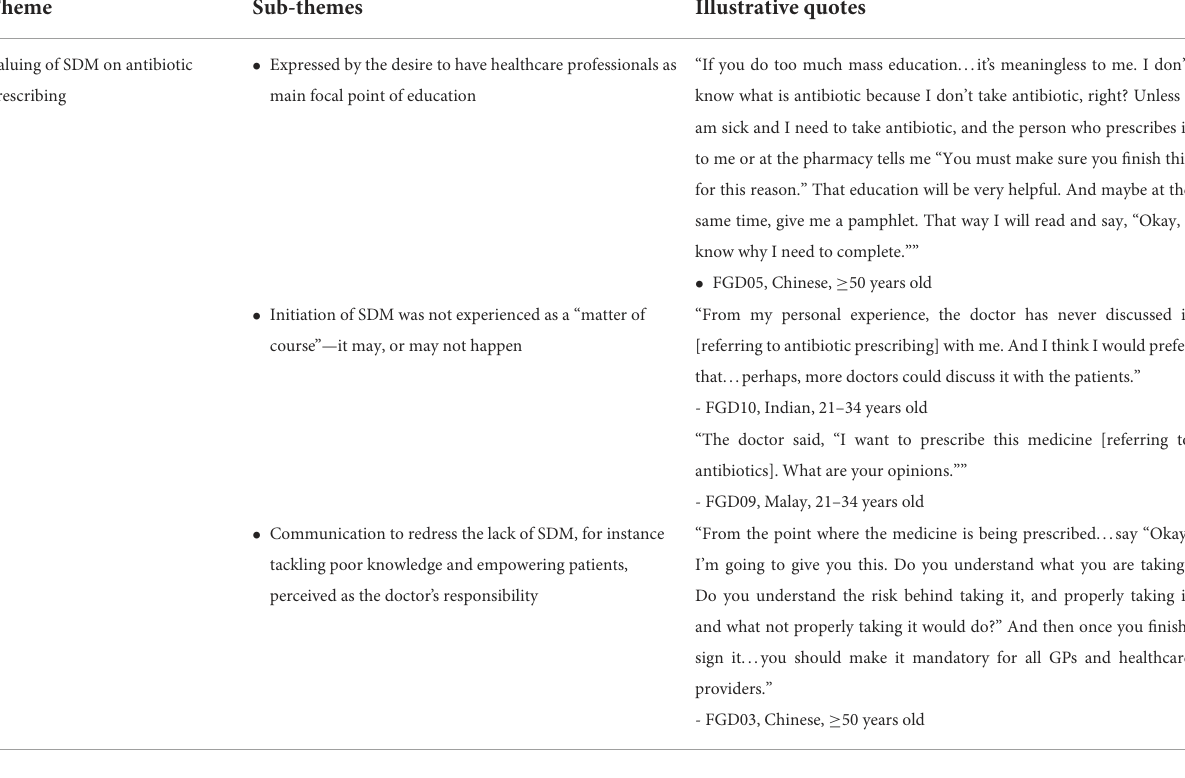
TABLE 3B Shared decision-making, themes collated from focus group discussion data.